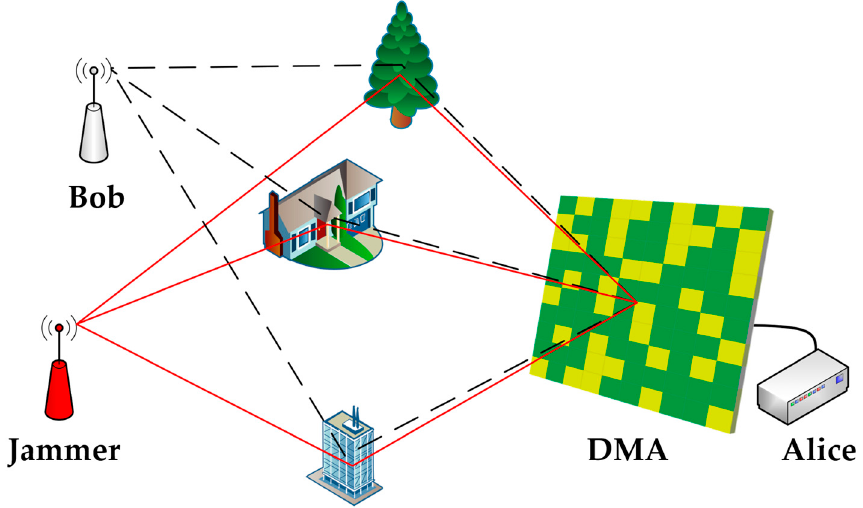
Figure 1. Multi-stream signal matched reception scenario based on DMA.